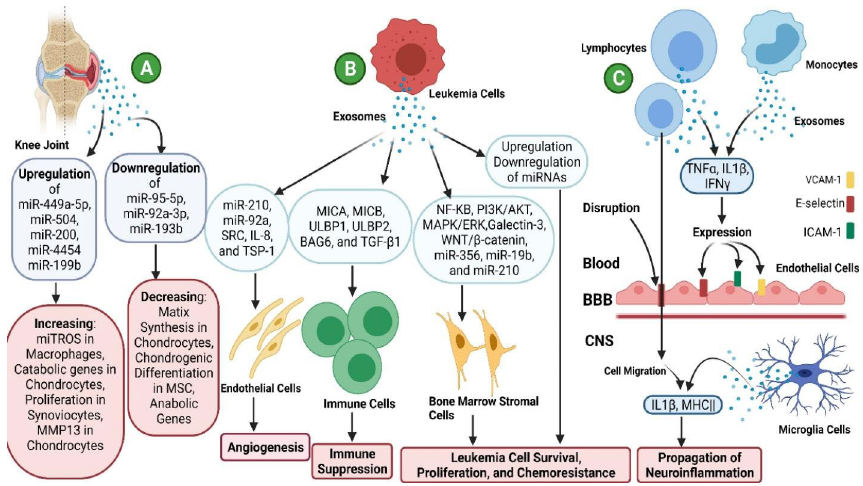
Fig. 1 Exosome Functions in B-cell Disorders : A) Chronic Lymphocytic Leukemia (AML), B)Multiple Sclerosis (MS), and C) Arthritis Rheumatoid